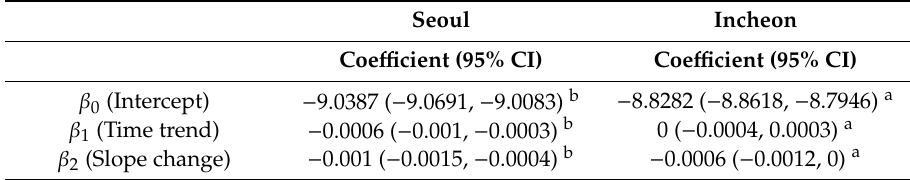
Table 3. Main results from controlled-interrupted time-series